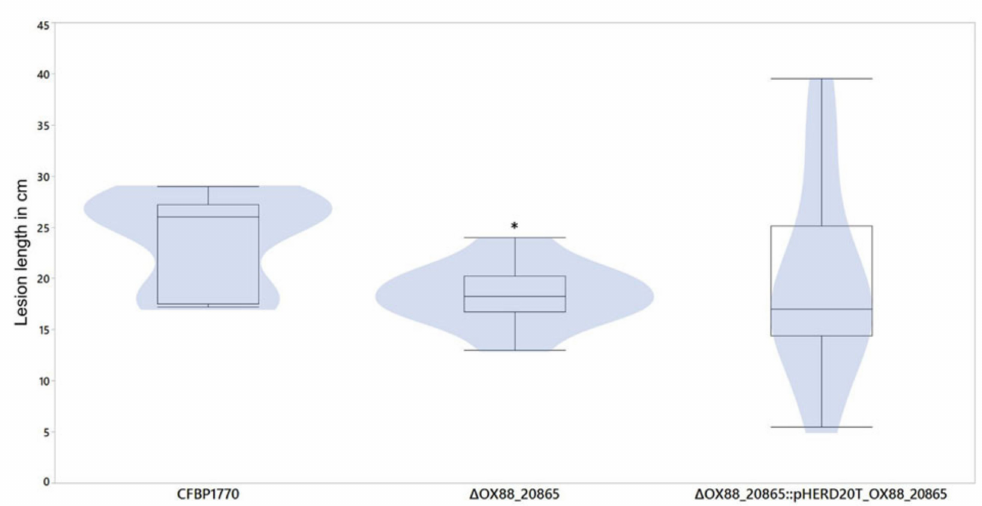
Figure 2. Virulence test on leek plants. The lesion length in cm of three di ff erent strains injected into the leaves. A significant di ff erence (*) between CFBP 1770 and CFBP 1770 ∆ OX88_RS20865 can be observed using a nonparametric Wilcoxon test ( p -value = 0.0148).